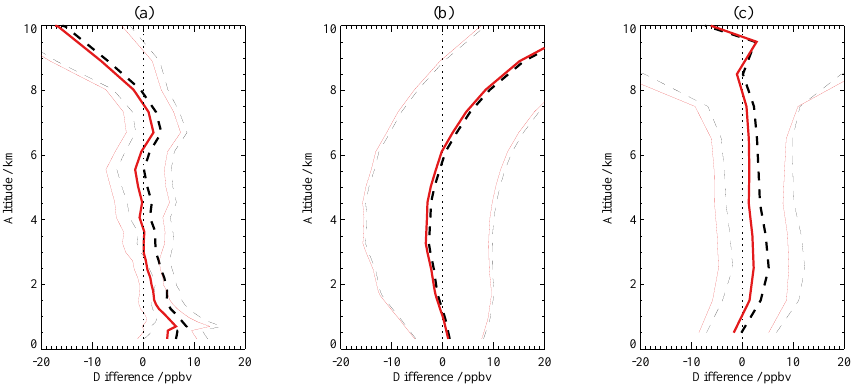
Fig. 13. Mean difference profiles (ppbv) of the model ozone output to (a) ozonesonde, (b) TES, and (c) IASI data averaged over the BORTAS-A campaign period (12 July to 4 August 2010). The model output is sampled at the time and location of the observed profiles for each dataset. Black dashed lines show the mean difference of the model output with the original FLAMBE inventory to the data and red solid lines show the difference of the model output with the scaled FLAMBE emissions derived from the MOPITT CO inversion. The thinner outer lines in each plot show the 1- σ standard